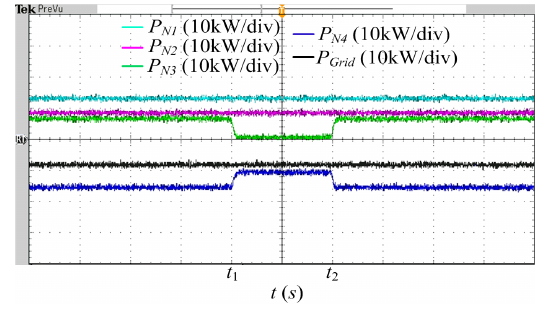
Figure 11. Microgrid active power